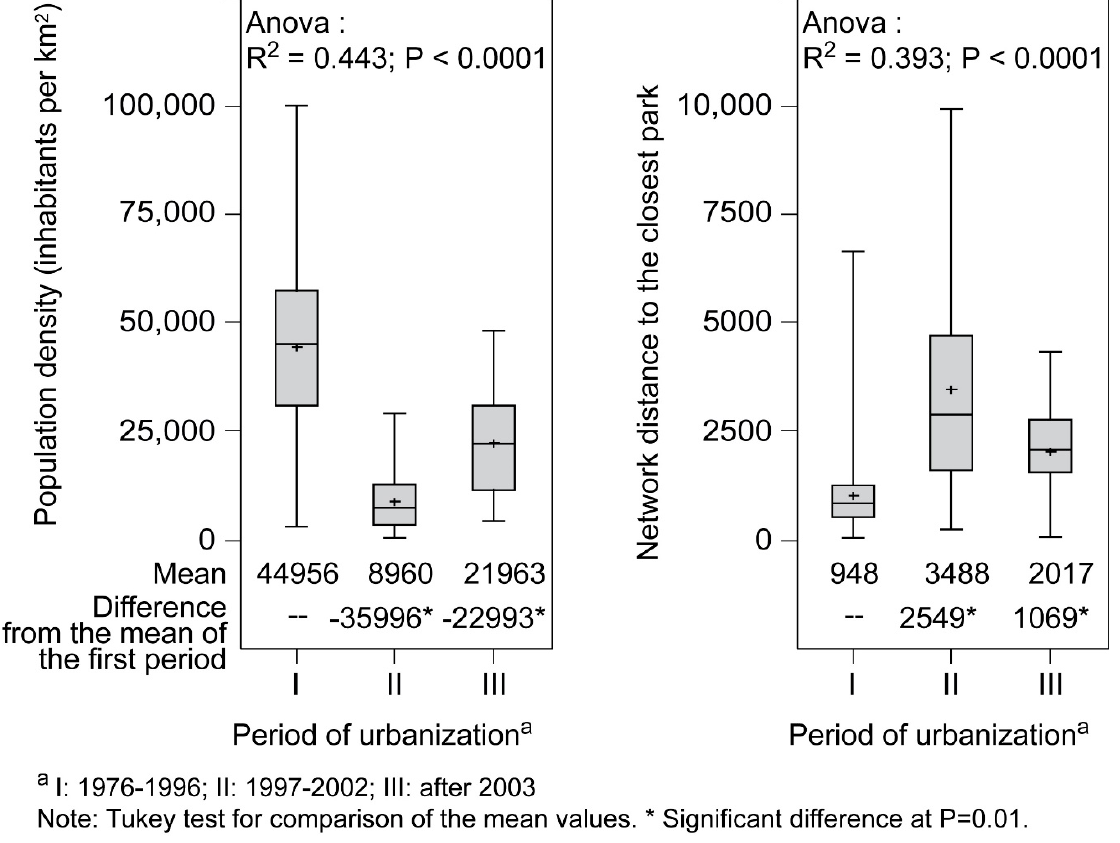
Figure 6. The link between the period of urbanization and population density in HCMC ( left ) and park accessibility ( right ).